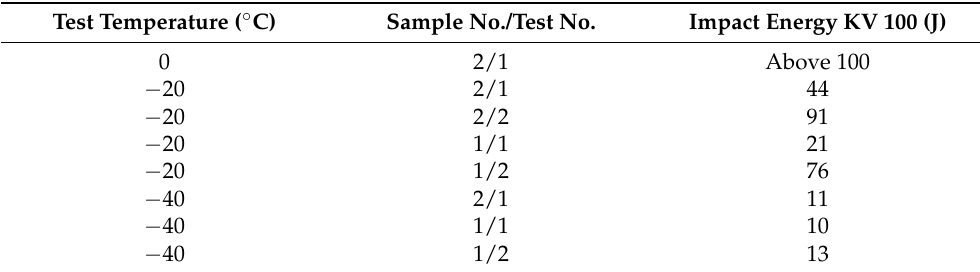
Table 2. The results of the impact strength tests of the samples taken from handy-size bulk carrier 30182 DWT.